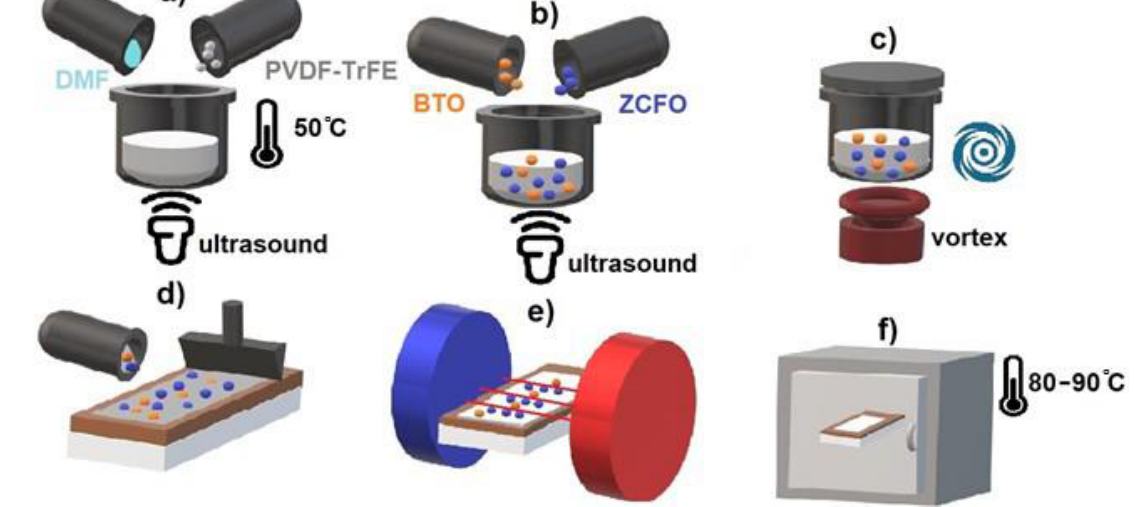
Figure 1. Scheme of the nanocomposite fabrication process. (a) Preparation of the base solution, (b) Adding fillers, (c) Blending, (d) Spreading, (e) Alignment in a magnetic field, (f) Evaporation.